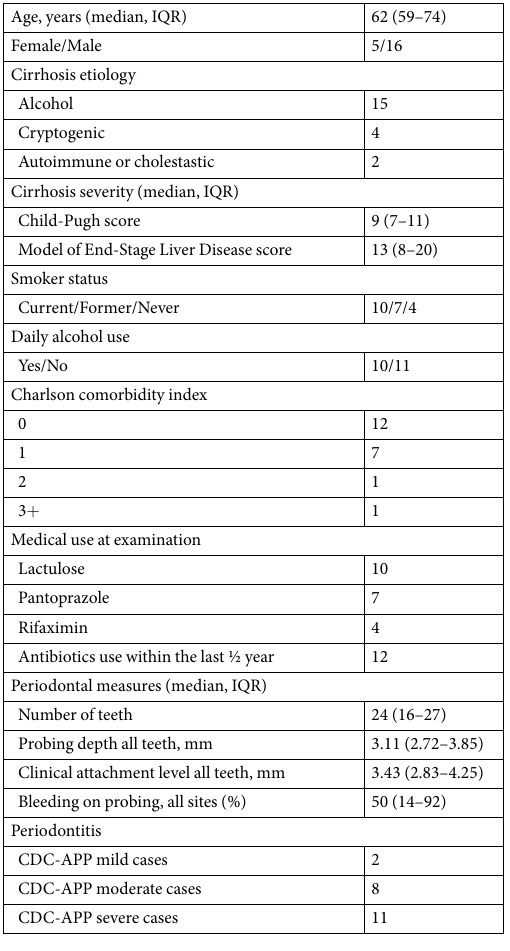
Table 1. Characteristics of the patient cohort (n = 21). IQR, interquartile